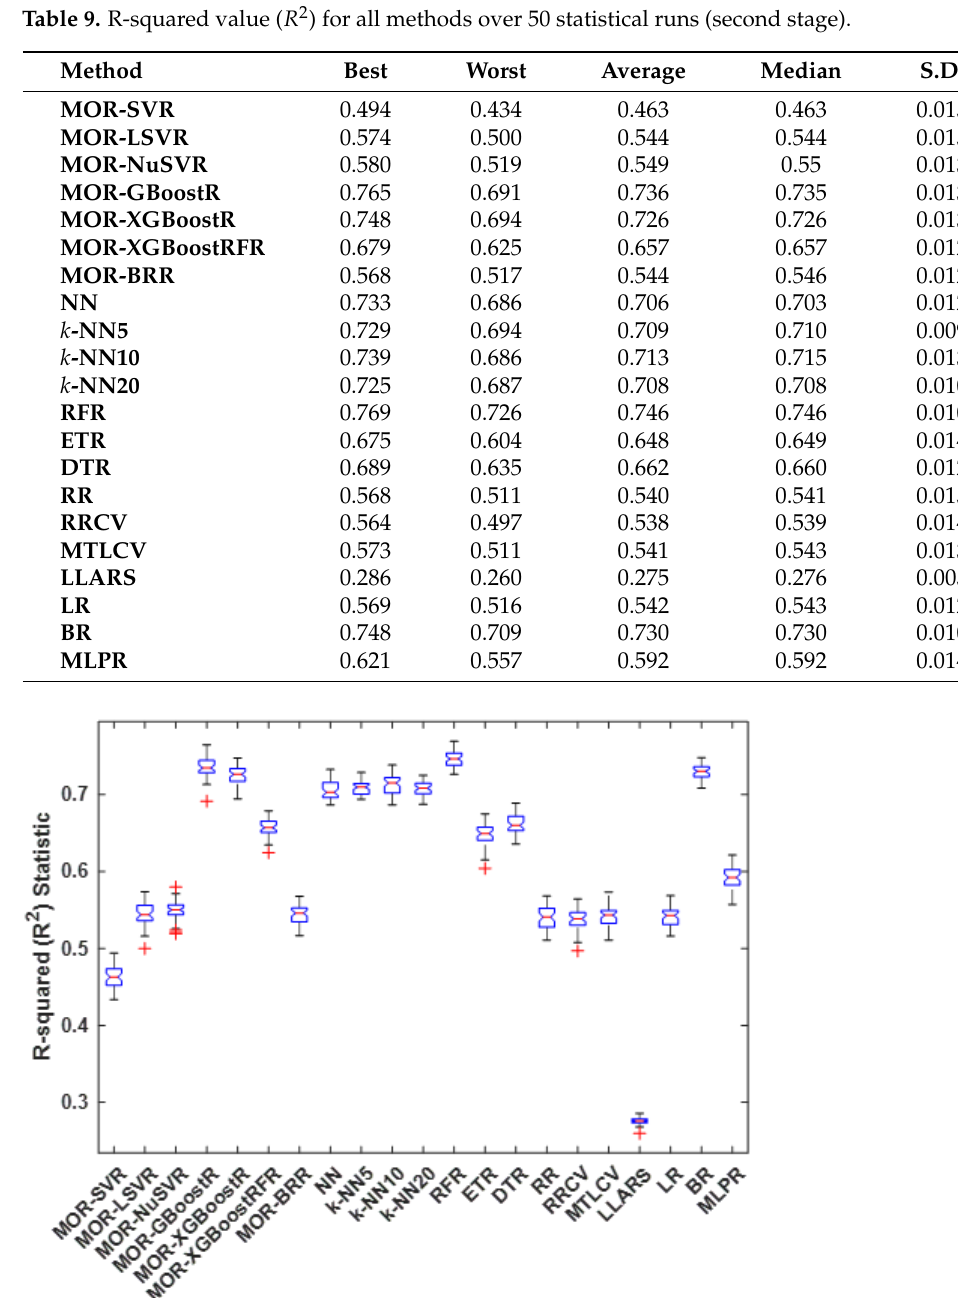
Figure 8. Box plots of R 2 statistic (over 50 statistical runs) for all methods for the second